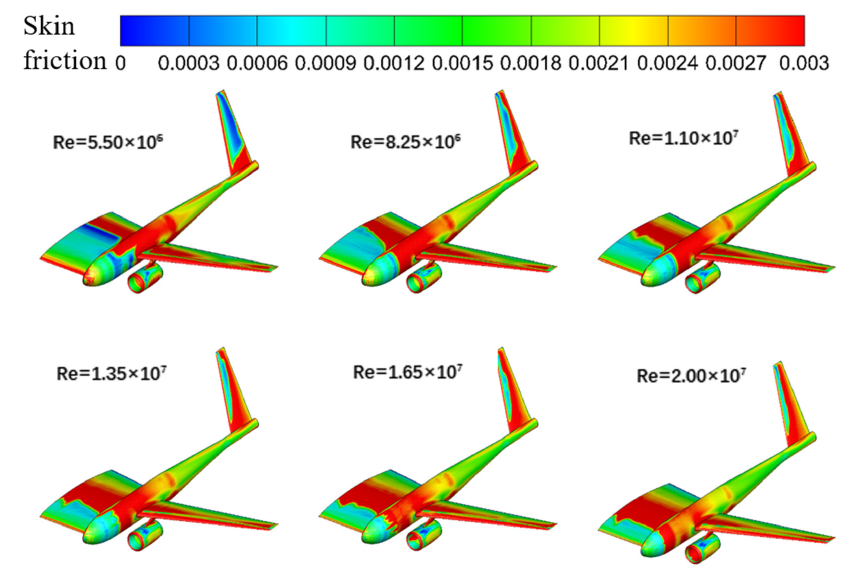
Figure 14. Skin friction coefficient contour of the whole aircraft with different Re .